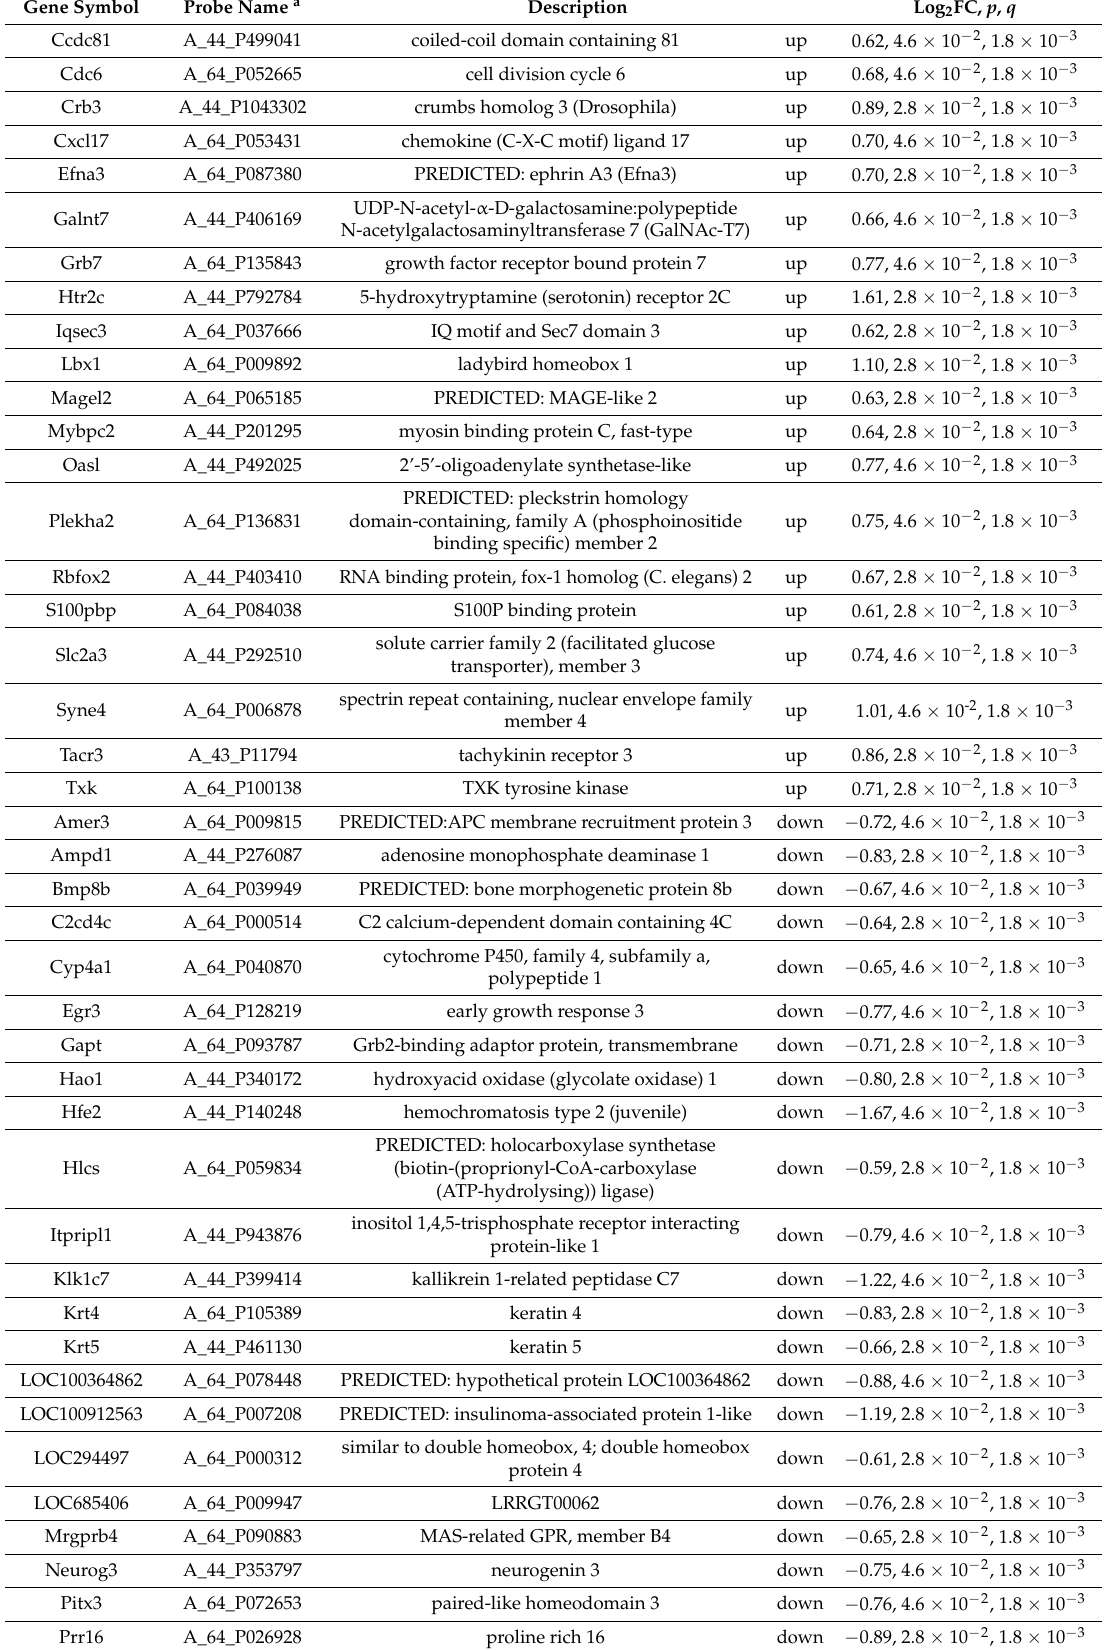
Table 4. DE genes unique to